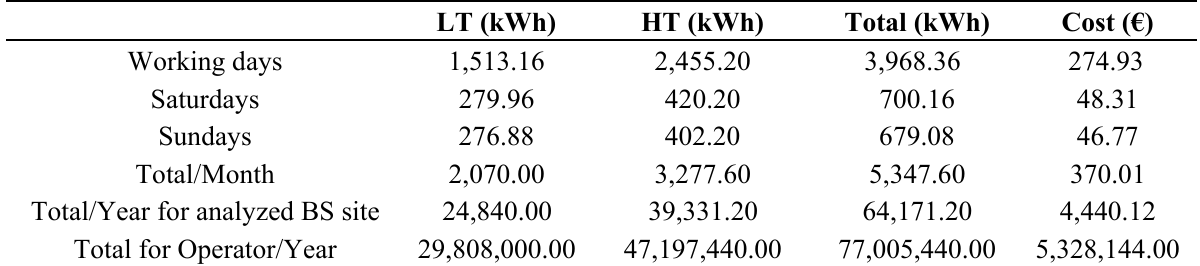
Table 5. Estimation of consumed energy consumption and corresponding financial